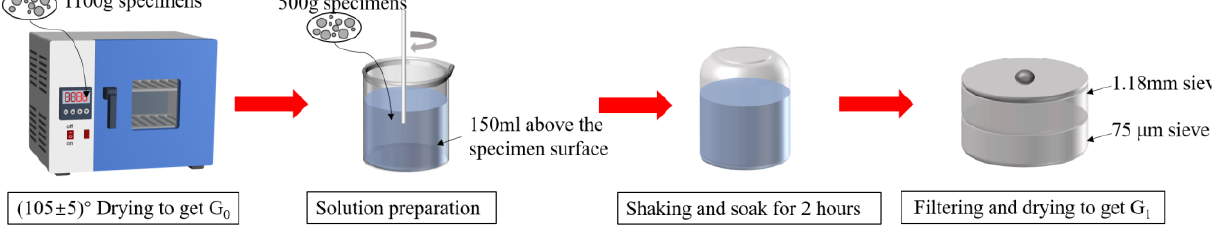
Figure 2. Clay content